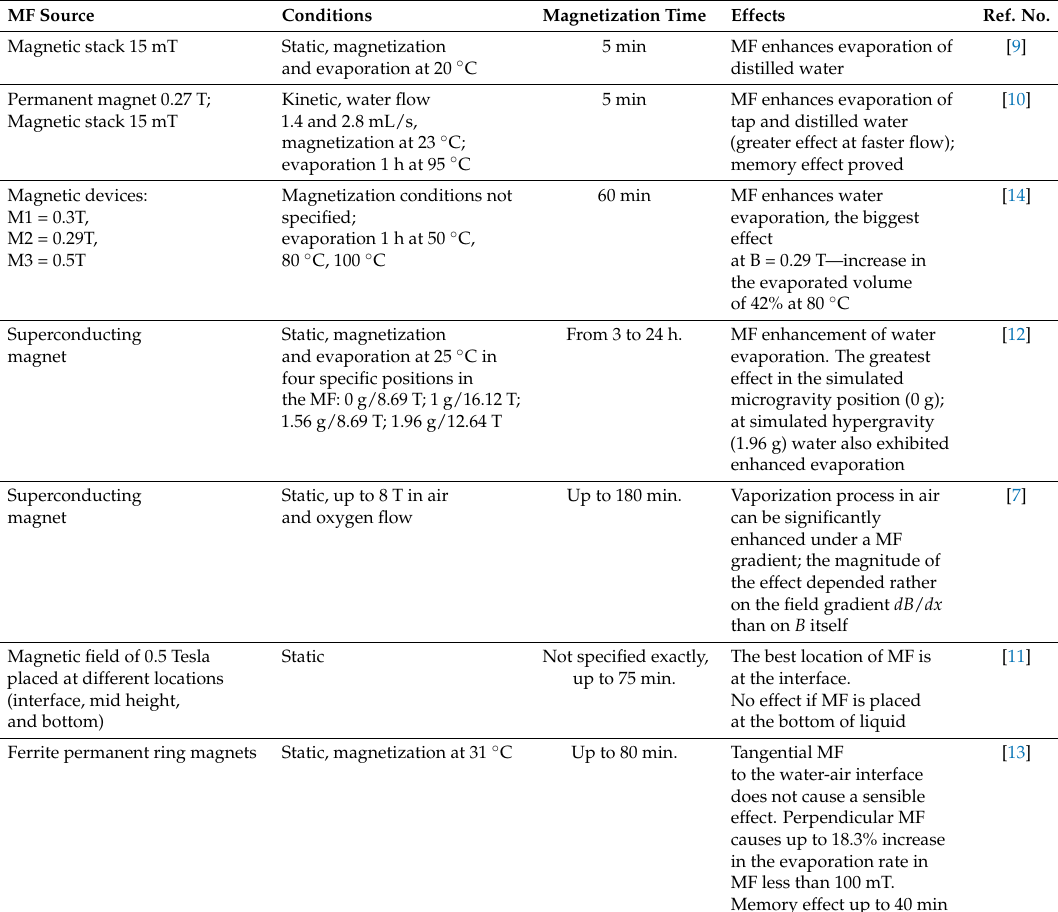
Table 1. Effects of static MF on water